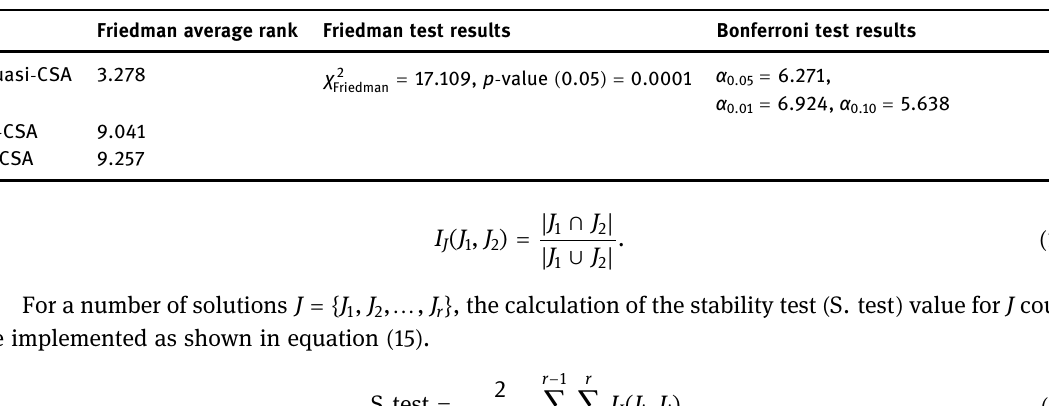
Table 4: Results of Friedman and Bonferroni tests of the methods over all